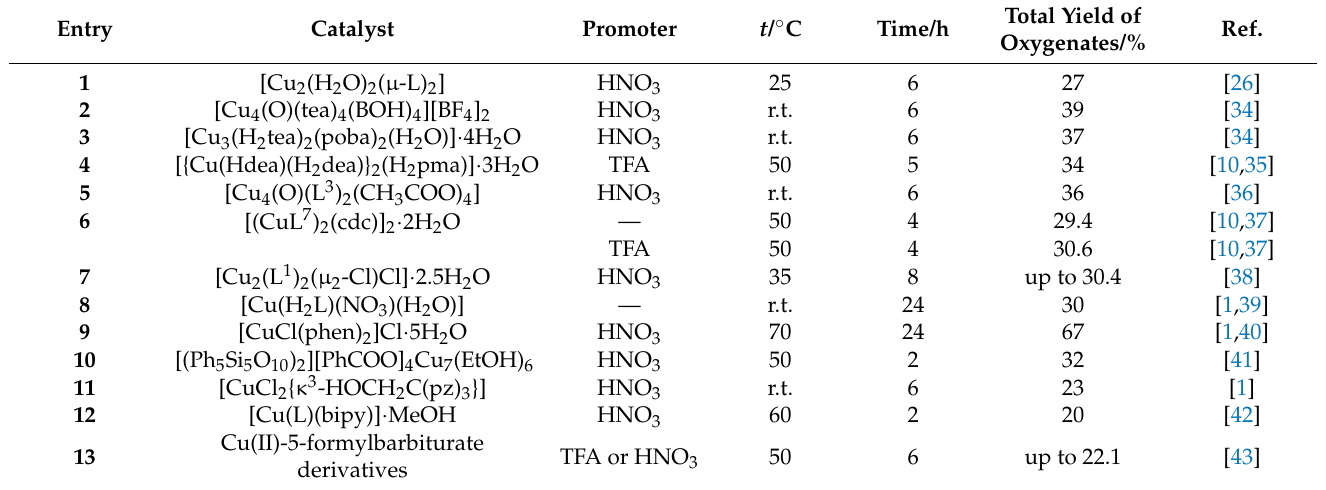
Table 6. Peroxidative oxidation of cyclohexane with H 2 O 2 catalyzed by several copper complexes in acetonitrile/water